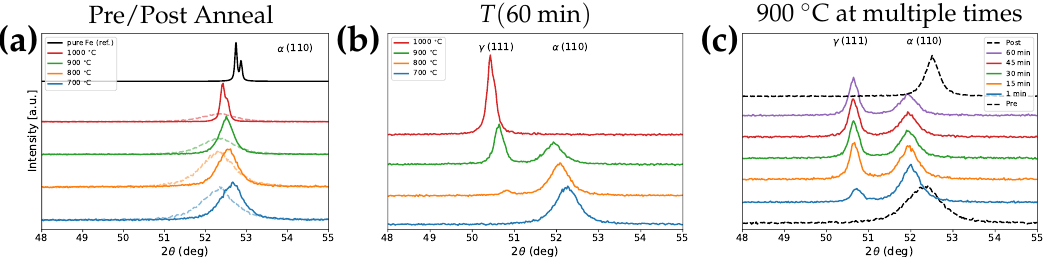
Figure 2. In situ XRD measurements were performed at different anneals, showcasing the instantaneous microstructural state. ( a ) pre (dashed) and post (solid) annealed alloys at RT showing the presence of α Fe 91 Ni 8 Zr 1 (bulk Fe reference was simulated with VESTA [44]), ( b ) after 60 min holds at the corresponding temperatures, and ( c ) 900 ◦ C anneal illustrating the nucleation and evolution of the γ